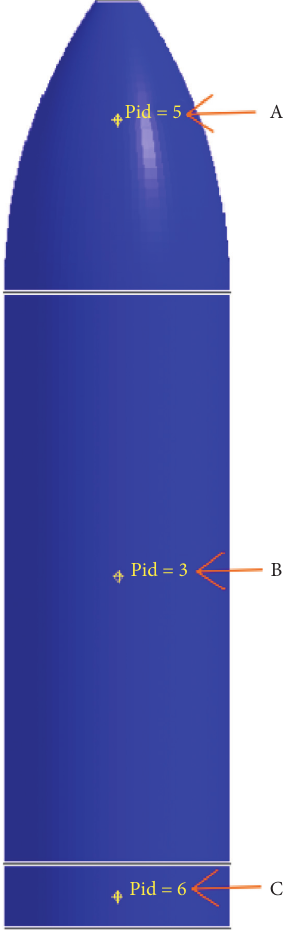
Figure 12: Missile parameter measurement point.